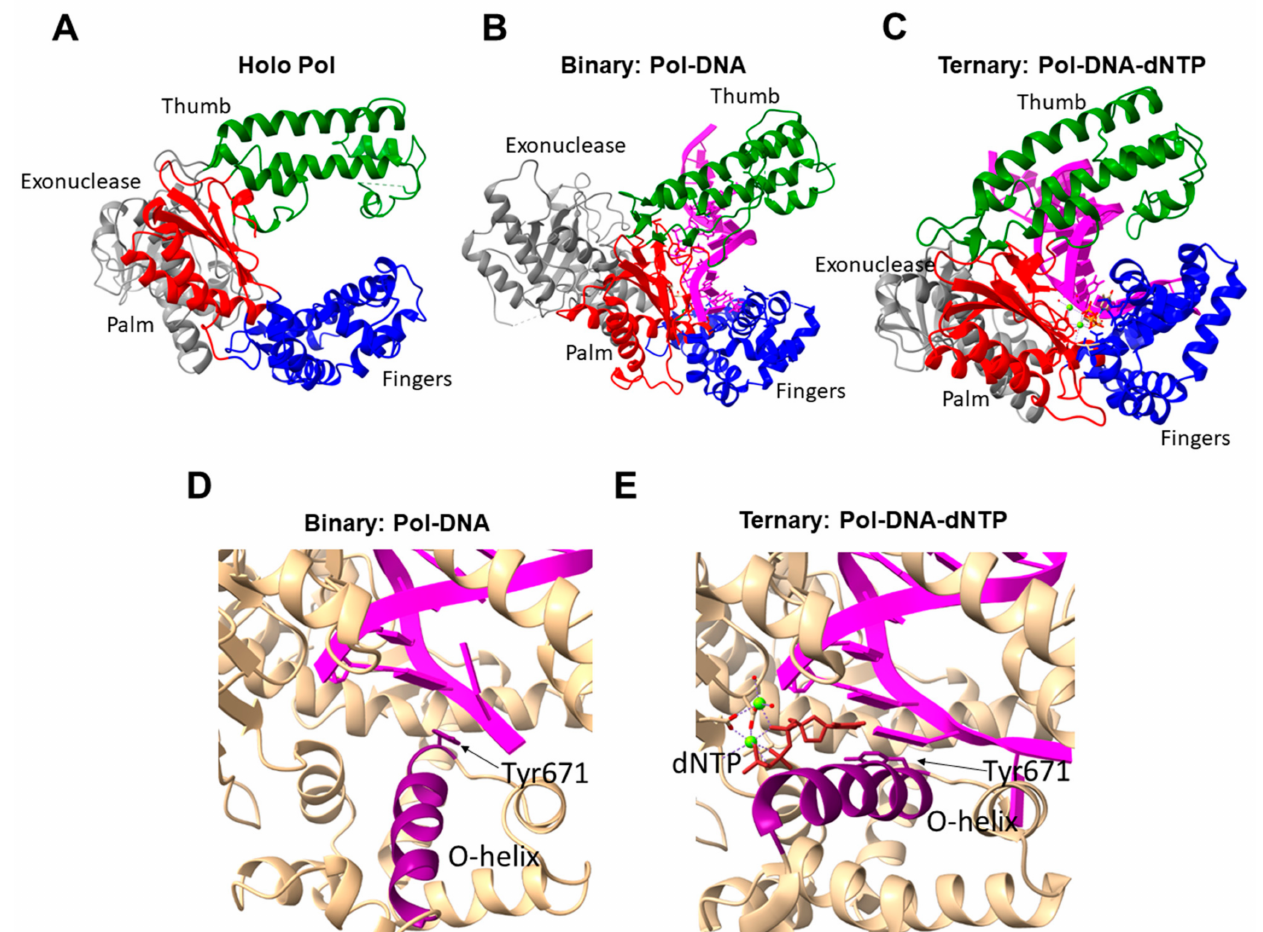
Figure 2. Three-dimensional structure of DNA polymerase I from E. coli : ( A ) holo enzyme (PDB ID 1ktq); ( B ) binary Pol-DNA (PDB ID 4ktq); ( C ) ternary Pol-DNA-dNTP (PDB ID 1qtm) complexes. The “thumb” and “fingers” subdomains are colored green and blue, respectively. The “palm” subdomain is red, “exonuclease” subdomain is grey, and DNA is magenta; ( D , E ) a detailed comparison of the active-site regions in the binary and ternary complexes. In each case, the protein is shown in beige, with the O-helix in purple. The incoming dNTP is colored in brown. The structure of the catalytic center of DNA polymerase ν differs from that of Pol θ in the unusual open state of the fingers domain; this conformation permits the binding of an incoming nucleotide, but not of its complementary base. How this specific feature affects the ability of Pol ν to go past lesions is still unclear